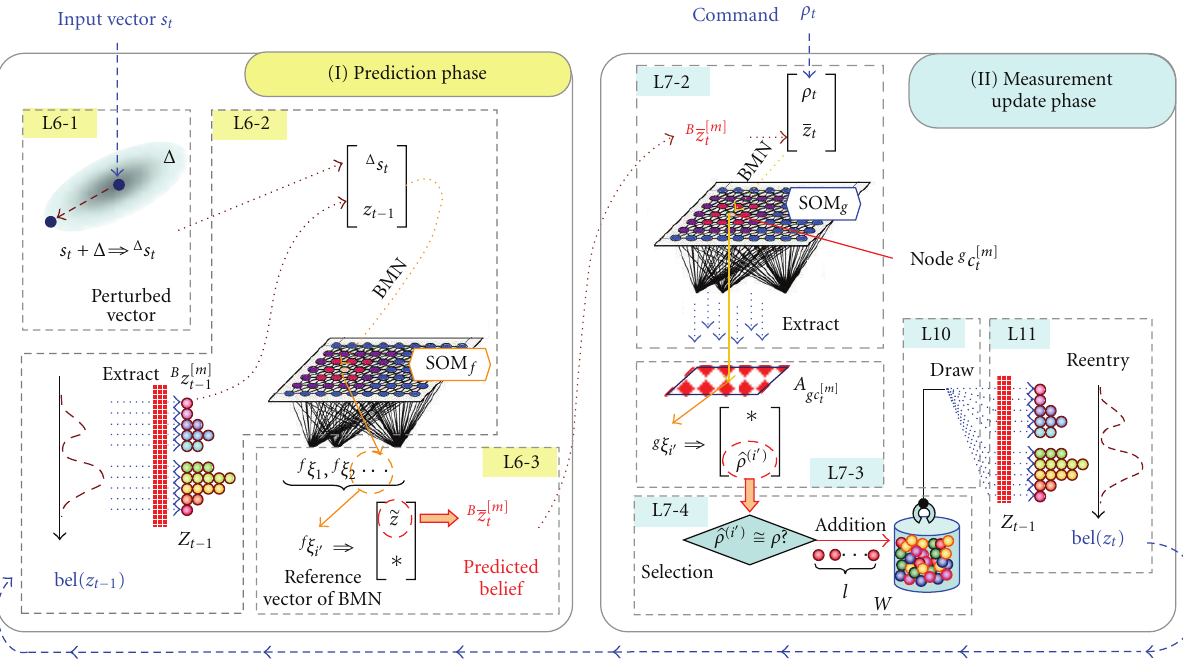
Figure 4: Algorithm of the SOM-Bayes estimator by particle